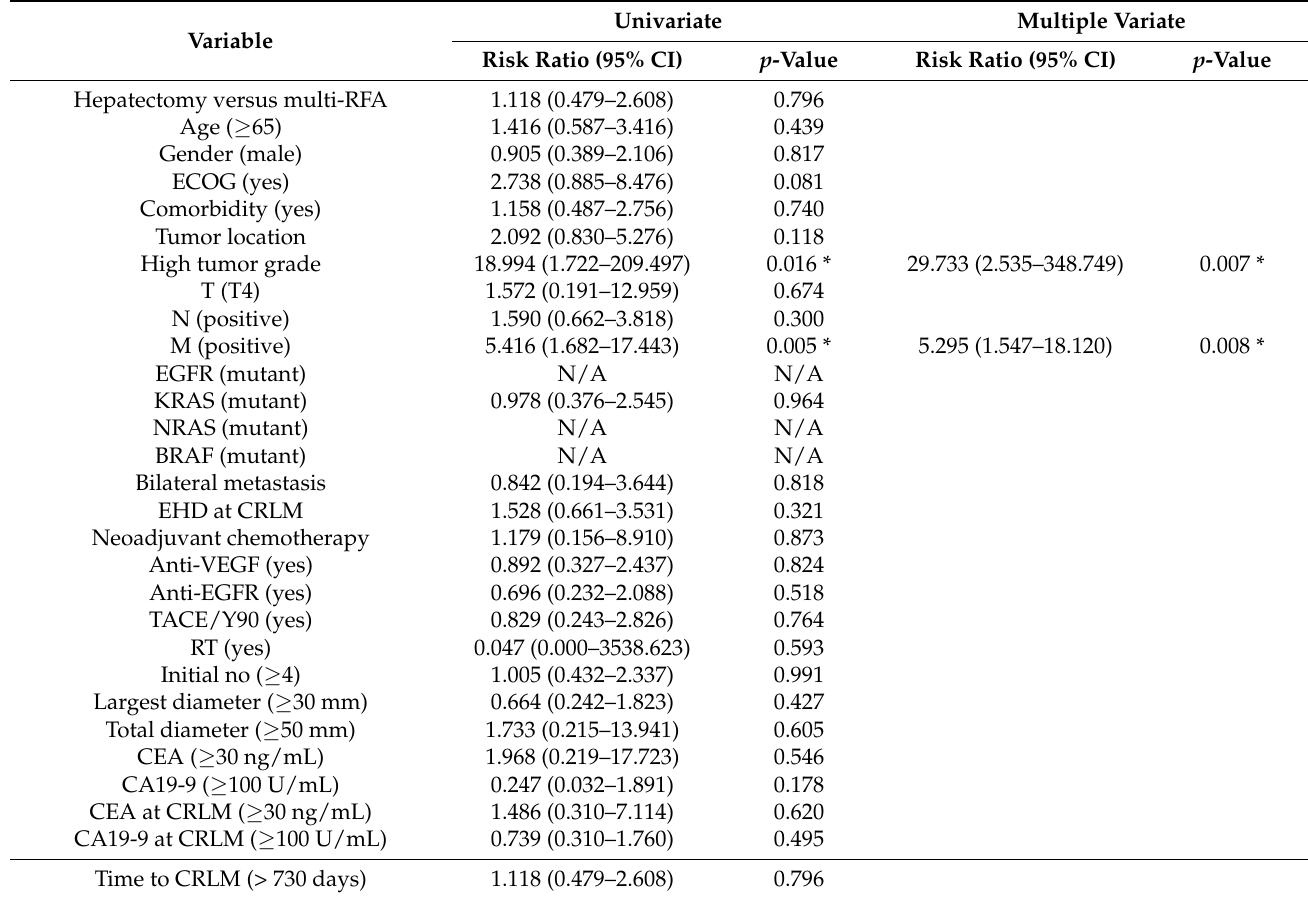
Table 8. Univariate analysis of multi-RFA vs. hepatectomy after